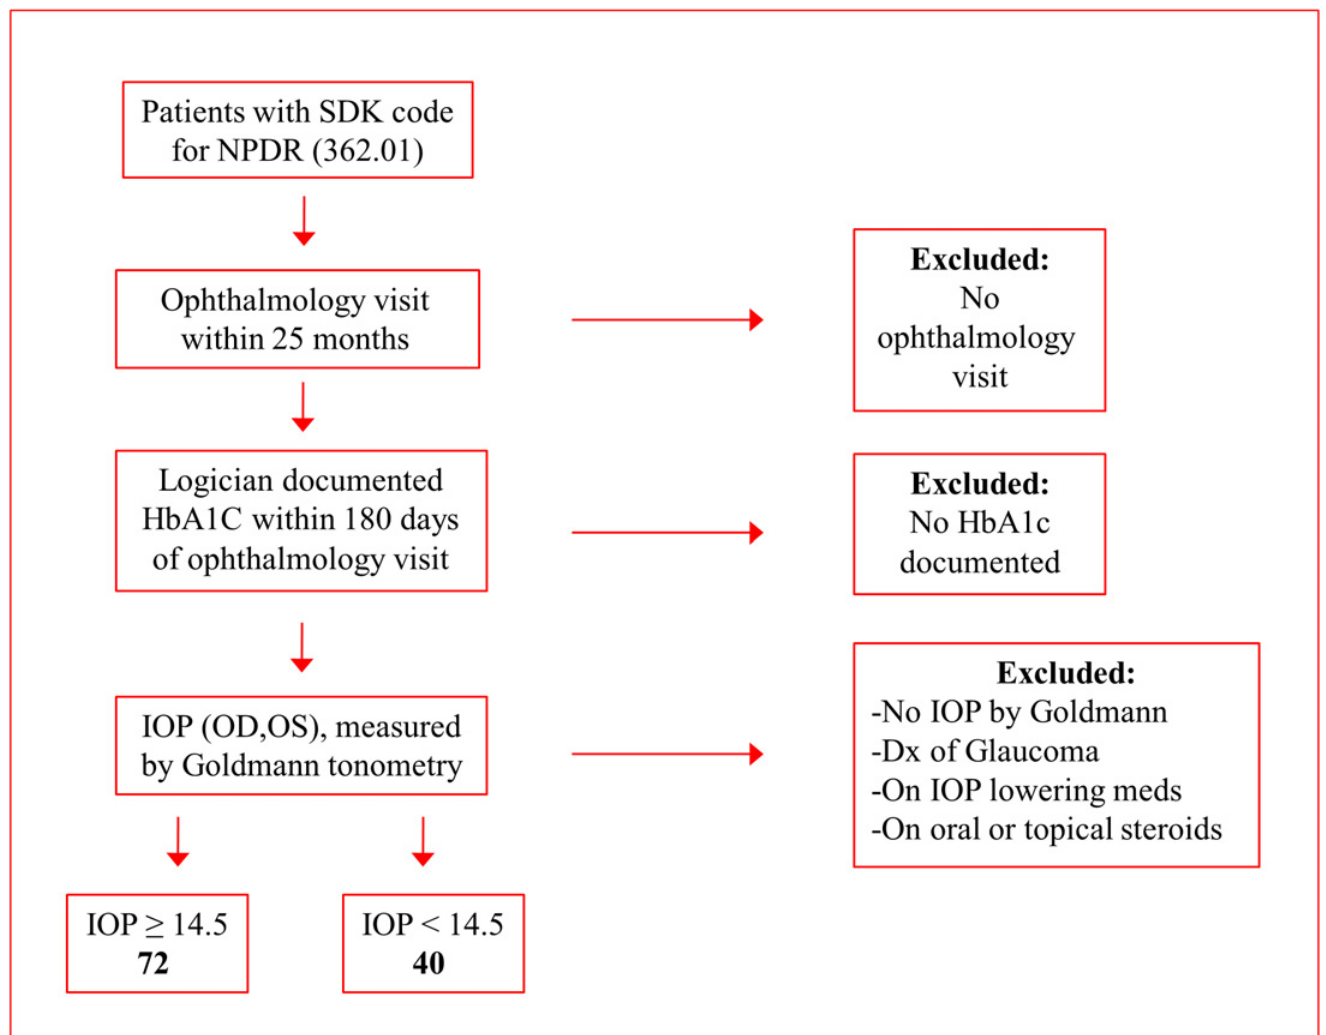
Fig 1. Derivation of study population. The data from diabetic individuals presented in this study were derived based on inclusion or exclusion criteria as shown in the flow